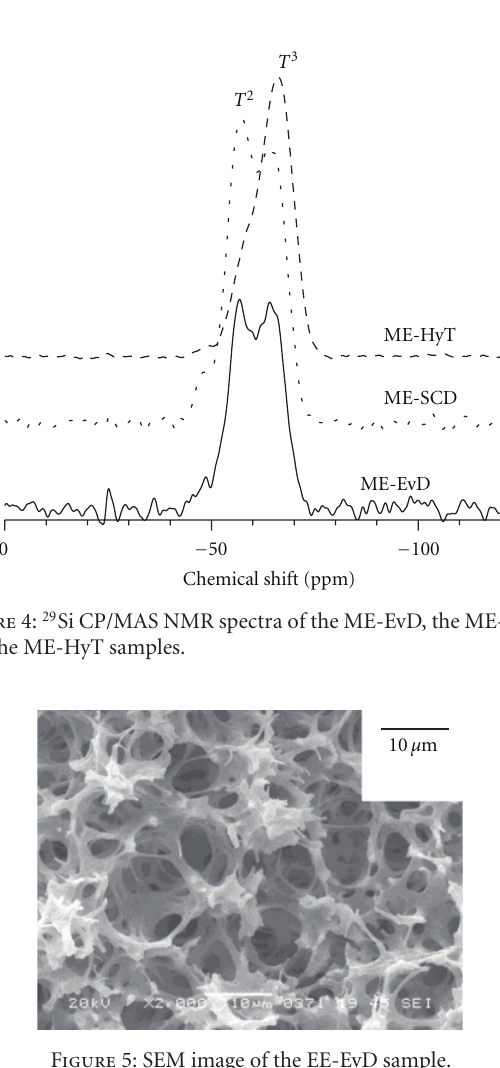
Figure 5: SEM image of the EE-EvD sample.